Question: What does this figure show? Answer in one sentence.
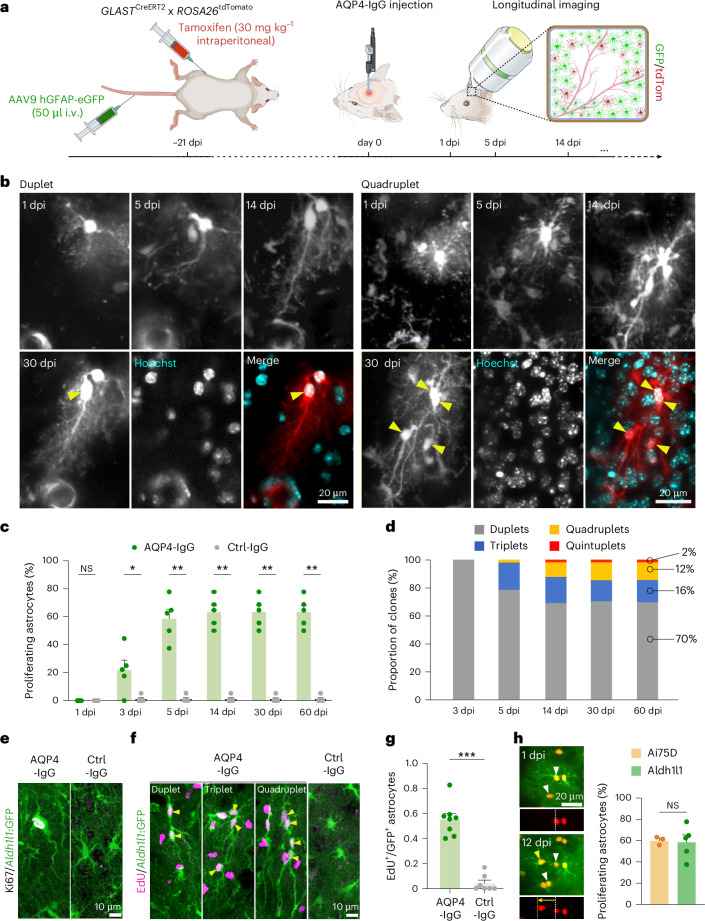
Answer: Perilesional astrocytes undergo multiple cell divisions. a , Sparse-cell labeling protocol for intravital two-photon imaging in GLAST CreERT2 x ROSA26 tdTomato mice allowing the monitoring of individual astrocytes over time. Schematic in a partly created in BioRender; Wyss, M. https://BioRender.com/ypewond (2026). b , Tracking single tdTom + astrocytes over time allows detailed morphological evaluation and shows the proliferative activity of single perilesional astrocytes with one (left) or more (right) daughter cells (yellow arrowheads) counterstained in vivo at the last imaging time point (30 dpi) with the nuclear stain Hoechst 33342 (Supplementary Video 2 ). c , Percentage of proliferating perilesional astrocytes, n = 5 mice for both conditions, AQP4-IgG and Ctrl-IgG. * P = 0.0476, ** P < 0.0079; Mann–Whitney test, two sided. d , Distribution of division cycles in proliferating perilesional astrocytes over time ( n = 5 mice). e – g , Immunohistochemical staining for Ki67 ( e ) and EdU ( f ) in astrocytes from AQP4-IgG-injected and Ctrl-IgG-injected areas. Yellow arrowheads indicate EdU + astrocytic clones. Ratio of EdU + to all GFP + perilesional astrocytes in both conditions ( g ); AQP4-IgG— n = 8 lesions from eight animals, Ctrl-IgG— n = 7 lesions from six mice. *** P < 0.001; Mann–Whitney test, two sided. h , Left: example from perilesional astrocytes 1 and 12 days after lesion induction in GLAST CreERT2 x Ai75D mouse line (Ai75D) illustrating proliferation of perilesional astrocytes (white arrowheads), and a translocation of a daughter nucleus (yellow arrowhead). Bottom: single channel showing the nuclear-localized tdTomato. Right: quantification of proliferating astrocytes in Ai75D mouse line compared to a cohort of Aldh1l1 GFP animals ( n = 3 and 5 mice, respectively; Mann–Whitney test, two sided). Data are represented as mean ± s.e.m. Schematic in a partly created in BioRender; Wyss, M. https://BioRender.com/ypewond (2026). Source data